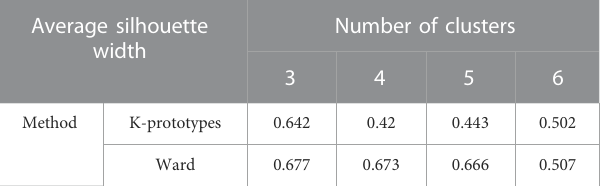
TABLE 4 Average silhouette width when using different methods and the number of